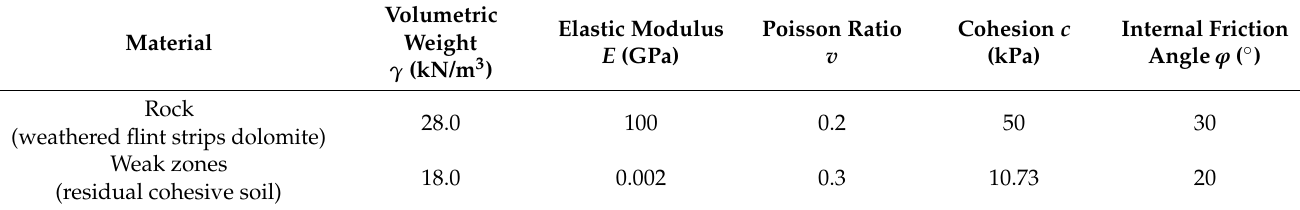
Figure 12. Schematic diagram of the distribution of weak zones (red zone represents weathered flint strips dolomite; blue zone represents weak zones). ( a ) Rotation angle of 30° around the X -axis; ( b ) rotation angle of 30° around the Y -axis; ( c ) rotation angle of 30° around the Z -axis; ( d ) rotation angle of 60° around the X -axis; ( e ) rotation angle of 60° around the Y -axis; ( f ) rotation angle of 60° around the Z -axis; ( g ) Rotation angle of 0°. Table 3. Material mechanical parameters of the slope.